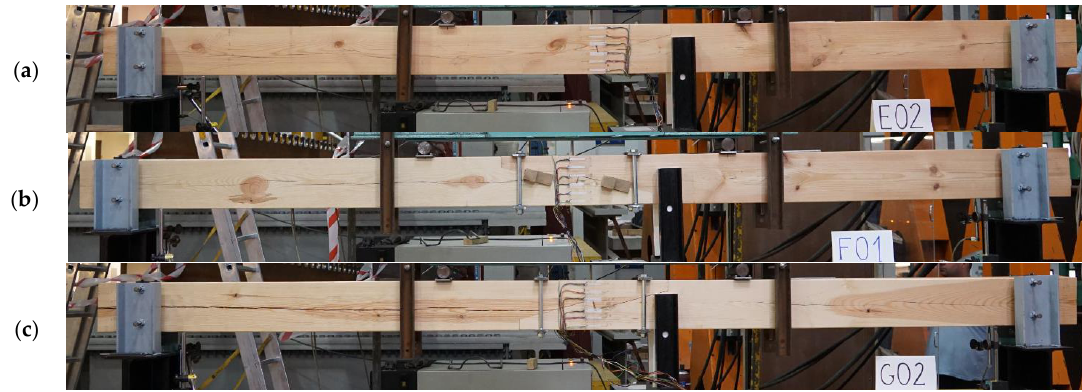
Figure 10. Axiometric schematics of joints used in the experimental models: ( a ) series E — with 2 drawbolts (double-sided tooth plate connectors type C10 + M10 screws), ( b ) series F — with wood inserts (and additional steel clamps), ( c ) series G — with steel clamps.